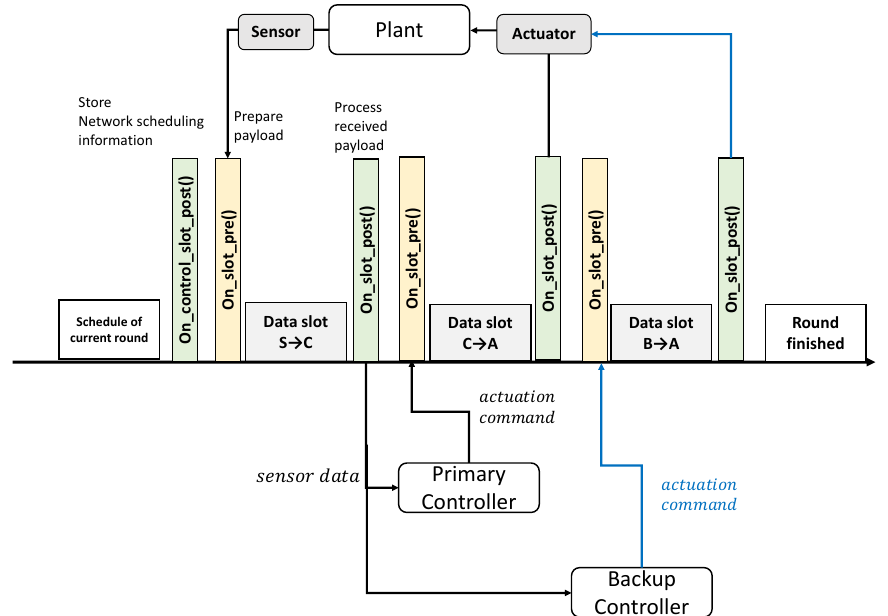
Figure 5. Implementation detail of scheduling with controller